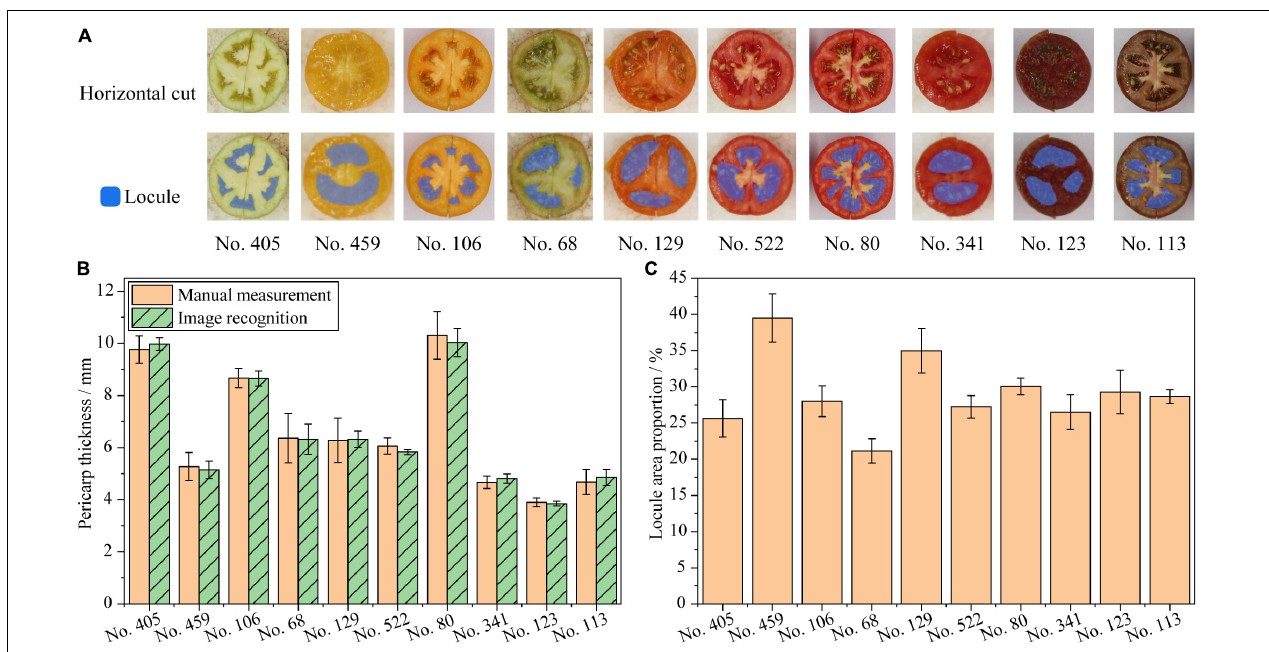
FIGURE 4 | Verification of phenotyping indicators from fruit horizontal cut images. (A) Fruit locule segmentation, fruit images are not proportional; (B) Pericarp thickness of tomato fruits; (C) Locule area proportions of tomato fruits.